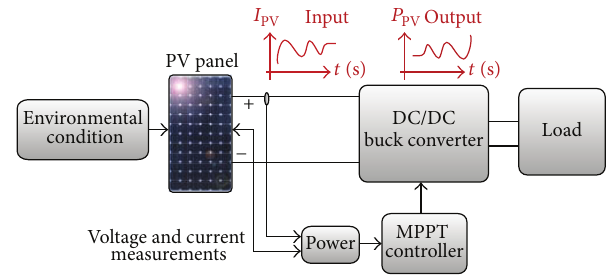
Figure 2: PV panel, MPPT, DC/DC buck converter, and a DC load.